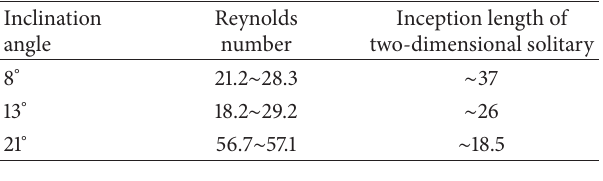
Table 1: Inception length of two-dimensional solitary.